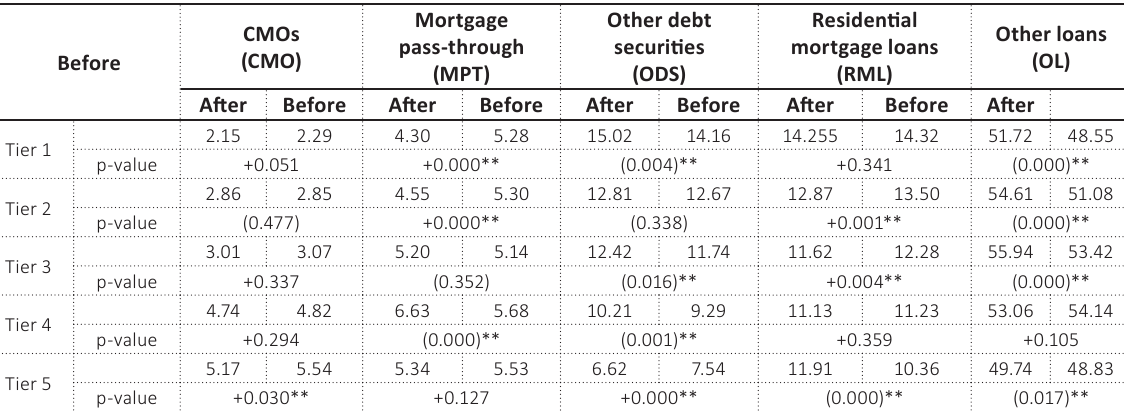
Table 3. T-test of change in average holdings of rate-sensitive asset categories before and after the financial